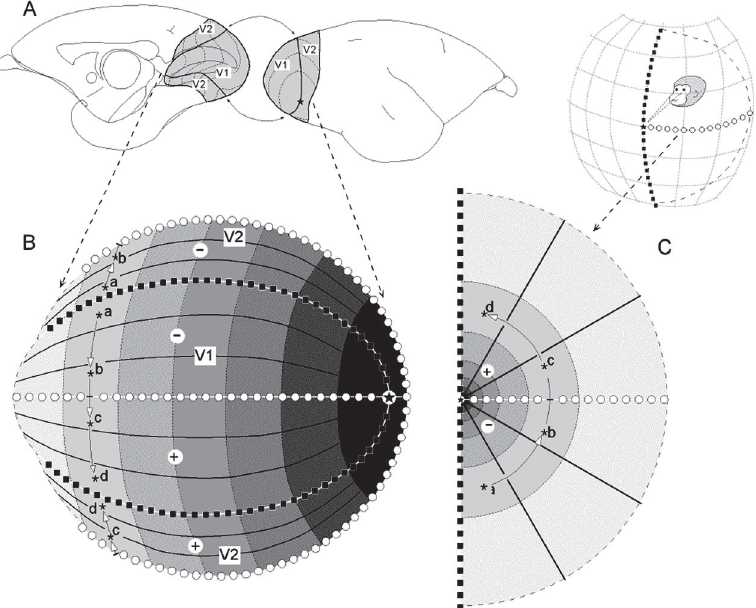
Figure 1. Visuotopic organisation of areas V1 and V2. A , Medial and lateral views of the right cerebral hemisphere of a marmoset monkey, indicating the locations of V1 and V2. In the medial view (top left) the banks of the calcarine sulcus have been separated to reveal portions of these areas. The star indicates the representation of the centre of the foveola, and isoeccentricity contours are indicated by fine dotted lines. The topological relationship between V1 and V2 on the medial and lateral surfaces is indicated by the arrows. B , A schematic unfolded representation of V1 and V2 indicating the locations of the representa- tions of different parts of the visual field. In this diagram, different visual field locations are indicated by different grey shades and symbols, which are summarised in a schematic view of the animal’s contralateral hemifield (C). The representation of the central 1 (cid:1) of the visual field is indicated in black, and progressively more eccentric parts of the visual field in gradually lighter shades of grey. Representations of the vertical meridian are outlined by the black squares, representations of the horizontal meridian by white circles, and those of the temporal perimeter of the visual field by dashed lines. The “+” and “-” signs indicate representations of the upper and lower contralateral quadrant, respectively. C , Schematic representation of the animal’s left hemifield, with four points located along an isoeccentric arc (a-d) indicated. Note that while the representation of this arc in V1 is continuous (B), in V2 it is not; points above and below the horizontal meridian project to non-adjacent sets of cortical columns in this area. In this and all subsequent figures, the visual hemifield is illustrated from the experimenter’s point of view (see top right of panel